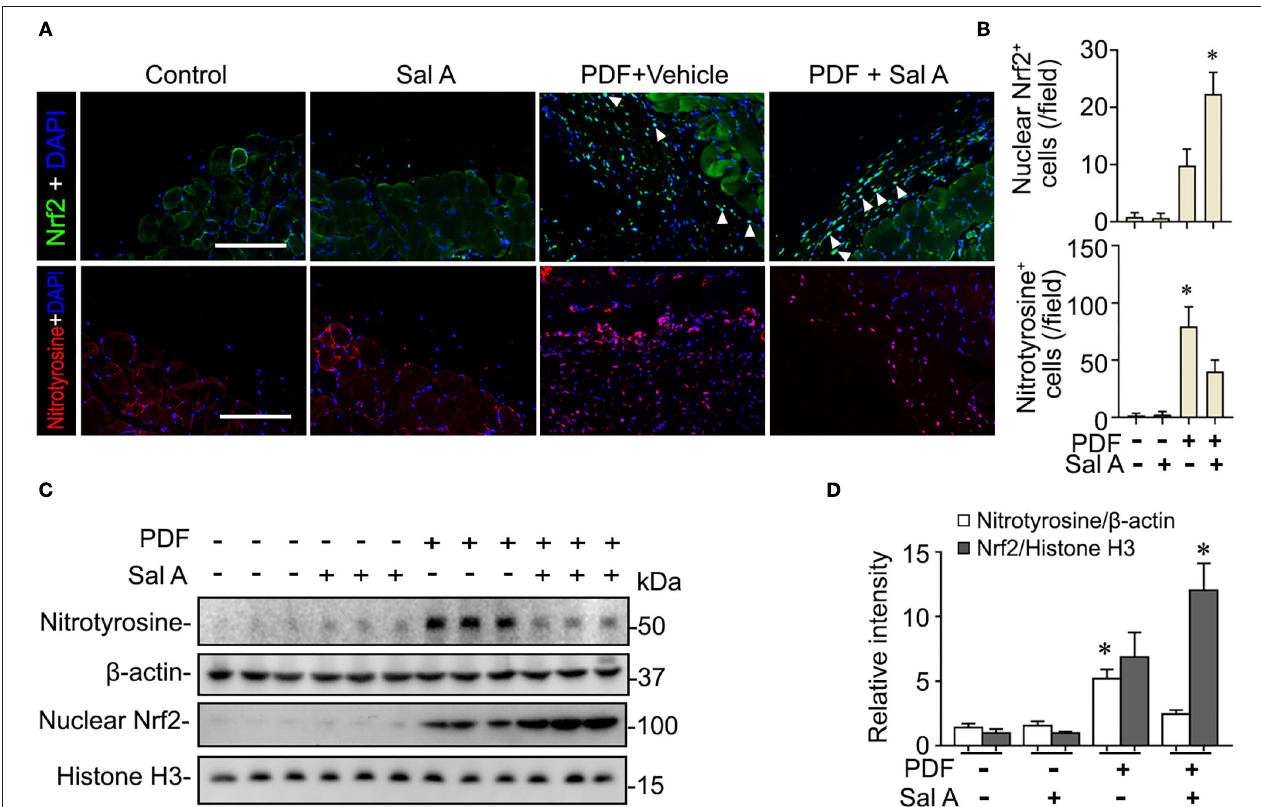
FIGURE 3 | Sal A treatment of murine models of peritoneal dialysis reinforces Nrf2 antioxidant response and diminishes oxidative damage in peritoneum. (A) Mice were treated as elaborated in Figure 2 . The peritoneal tissues were collected on week 7 and subjected to fluorescence immunohistochemistry staining for indicated proteins. The arrowheads indicate nuclear Nrf2 positive cells. Scale bar = 200 µ m. (B) Absolute counting of nuclear Nrf2 or nitrotyrosine positive ( + ) cells. Data were analyzed by one-way ANOVA followed by Tukey’s test. * P < 0.05 vs. other groups ( n = 6). (C) Representative immunoblots showing immunoblot analysis of peritoneal tissues for indicated molecules. (D) Relative abundance of indicated proteins, as normalized to that of β -actin or histone based on densitometric analyses of immunoblots ( n = 6). Data were analyzed by one-way ANOVA followed by Tukey’s test. * P < 0.05 vs. other